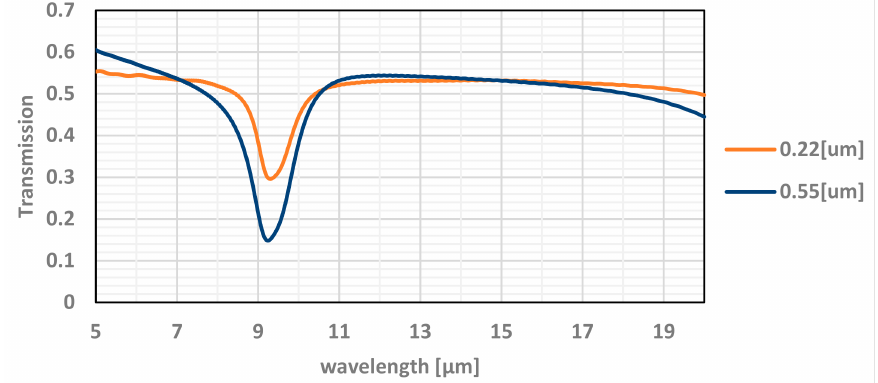
Figure 7. The simulated optical transmittance of the TMOS optical window for different silicon dioxide thickness as a function of the wavelength. The simulated results are in good agreement with measured